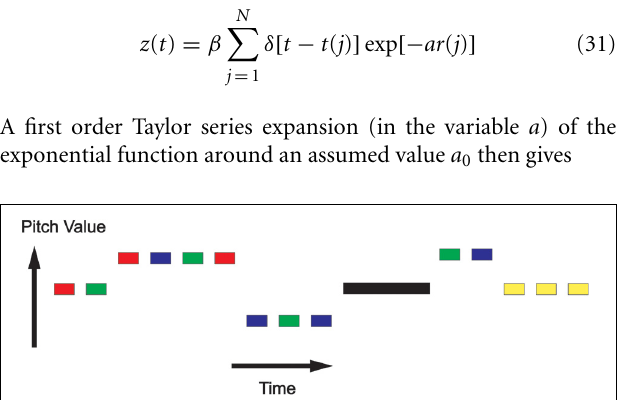
FIGURE 3 | Magnitude of initial response, β k averaged over sessions, for conditions k = 1 , 2 , 3 , 4 (Harmonic Complex—HC, Click Train—CT, Random Interval Noise—RIN, Noise). The red error bars indicate the